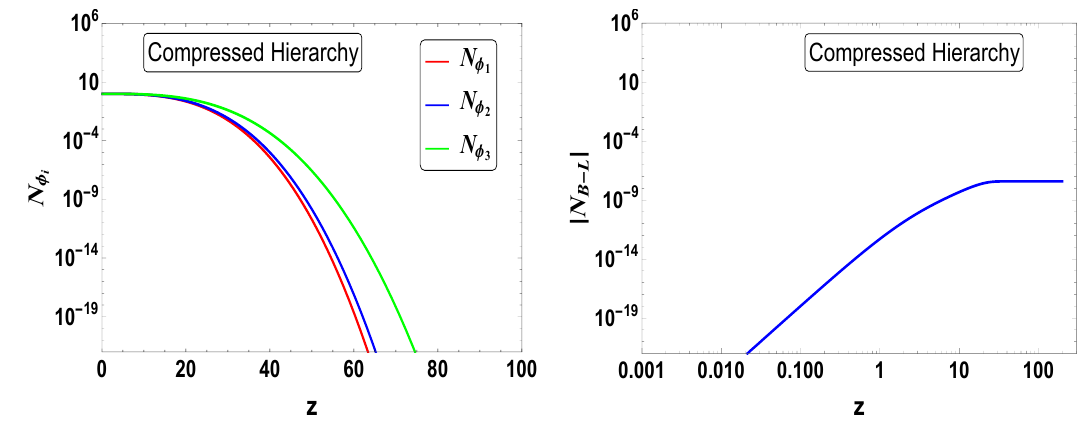
Figure 11 . Evolution of N φ (left) and N B − L (right) as a function of temperature T considering i compressed mass hierarchy among the scalars with { M φ → 10 7 , 10 7 . 1 , 10 7 . 2 } GeV and T r = 0 . 1 GeV i for the benchmark point I in table 2.